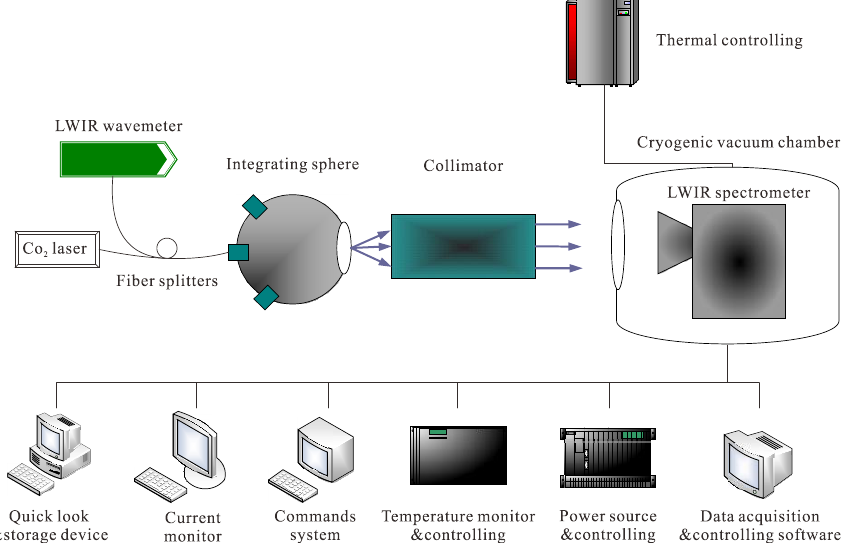
Figure 13. Layout of the refocusing test system.